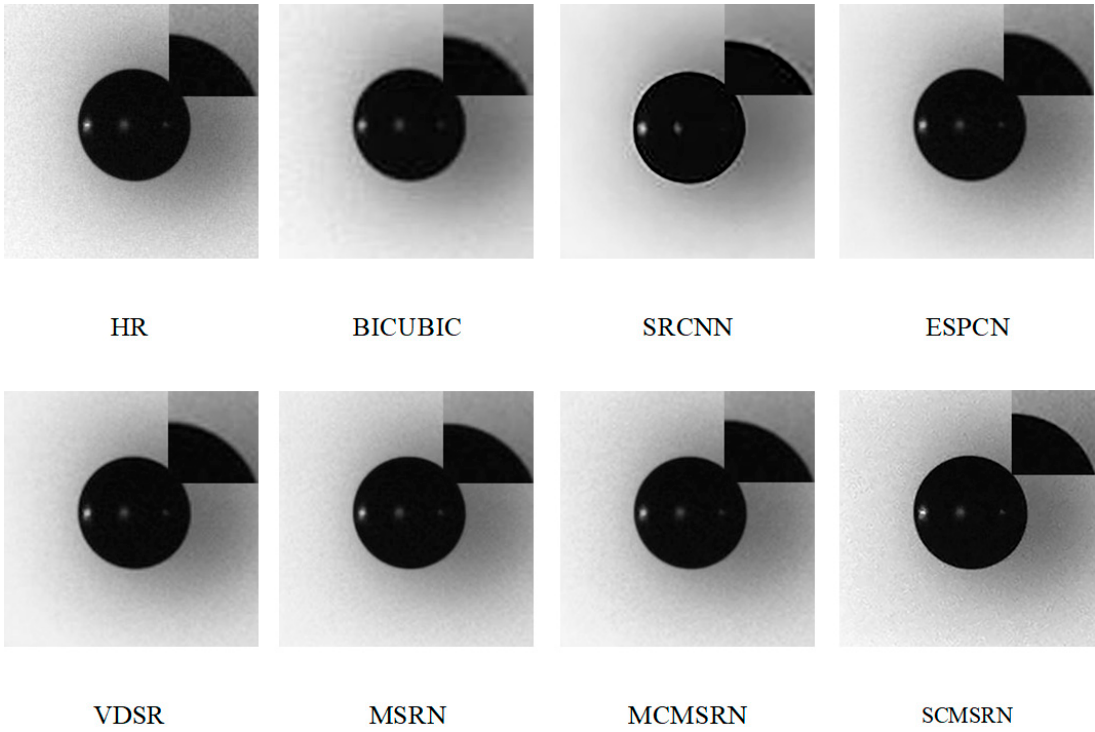
Figure 6. Comparison of the local effects of various algorithms on the melt image of liquid metal samples x2.